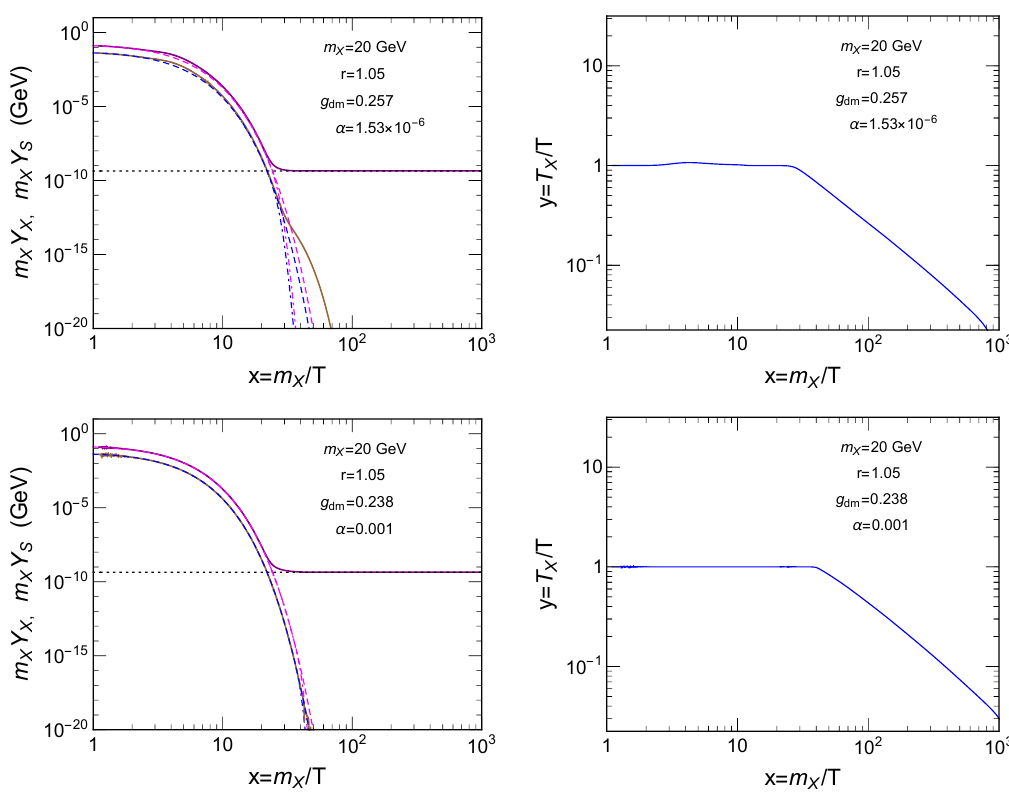
Figure 4 . Right panel: y = T X /T (= T S /T ) vs. x (= m X /T ) , where T is temperature of the bath. Left panel: m X Y X (purple solid line) and m X Y S (brown solid line) as functions of x . The magenta and blue dashed lines (or dotdashed lines) depict the corresponding ones following Boltzmann suppression with T X = T (or with their actual temperature). Here, the DM freeze-out yield can lead to the correct relic abundance denoted by the horizontal dotted